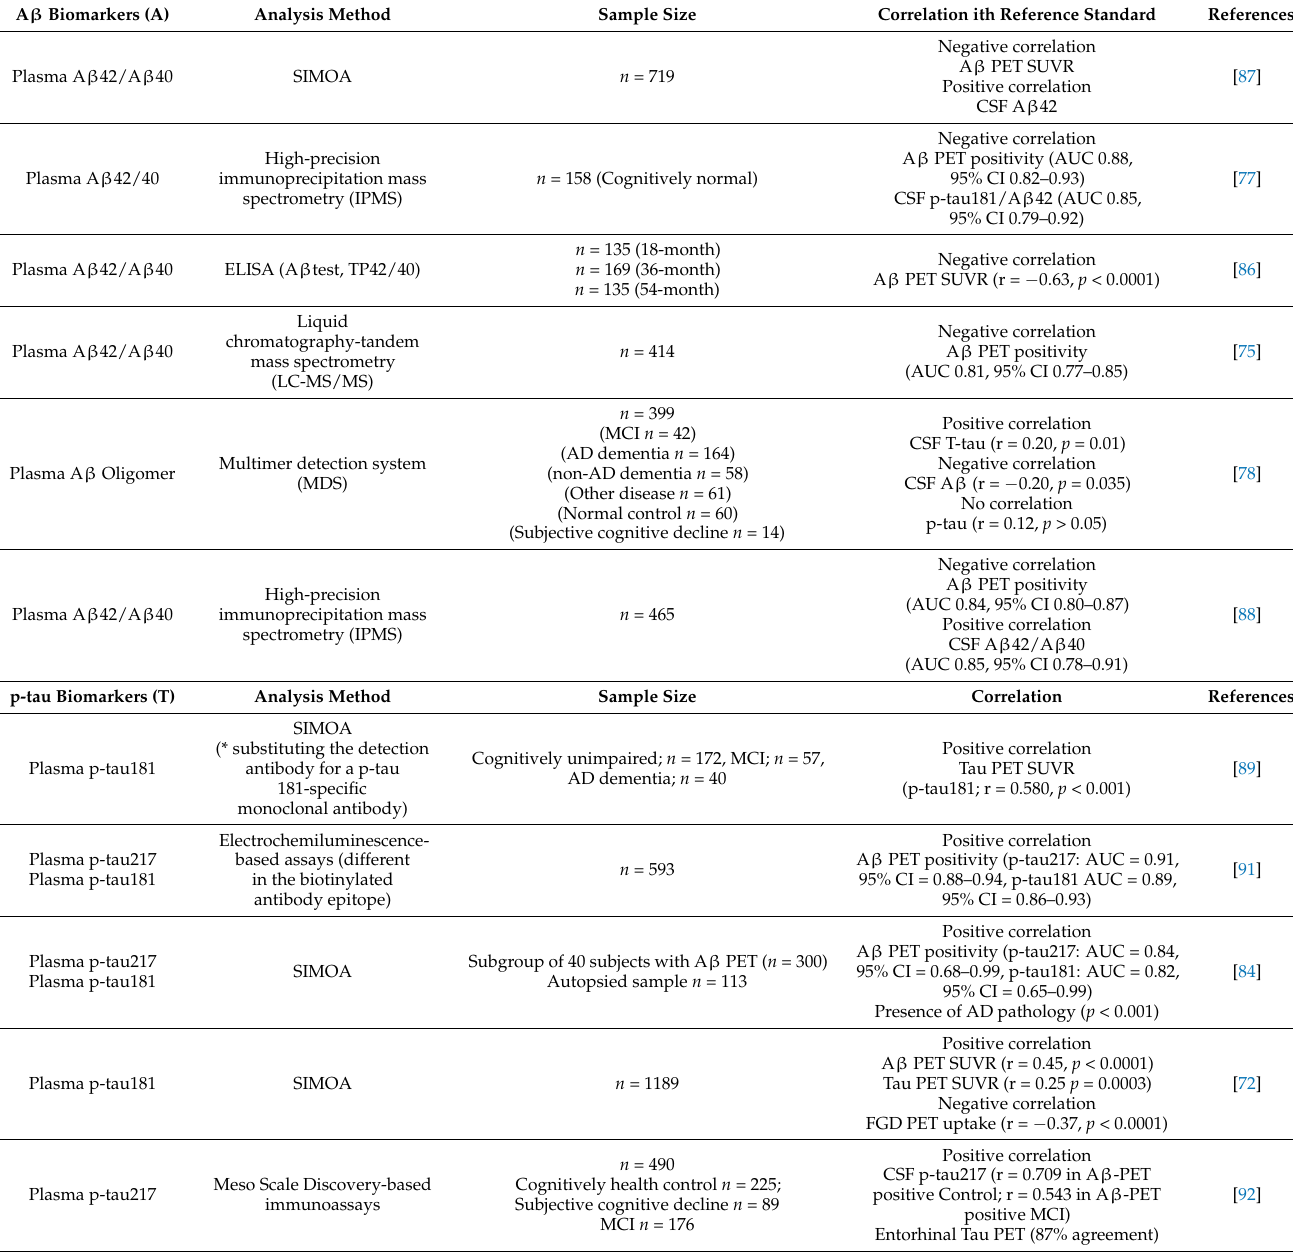
Table 1. The correlation between plasma blood biomarkers and core CSF biomarkers or brain